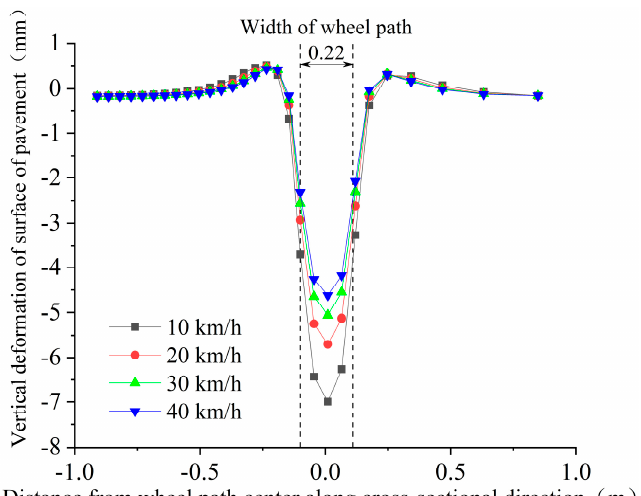
Figure 17. Permanent vertical deformation of road surface in cross-sectional direction at different vehicle speeds.